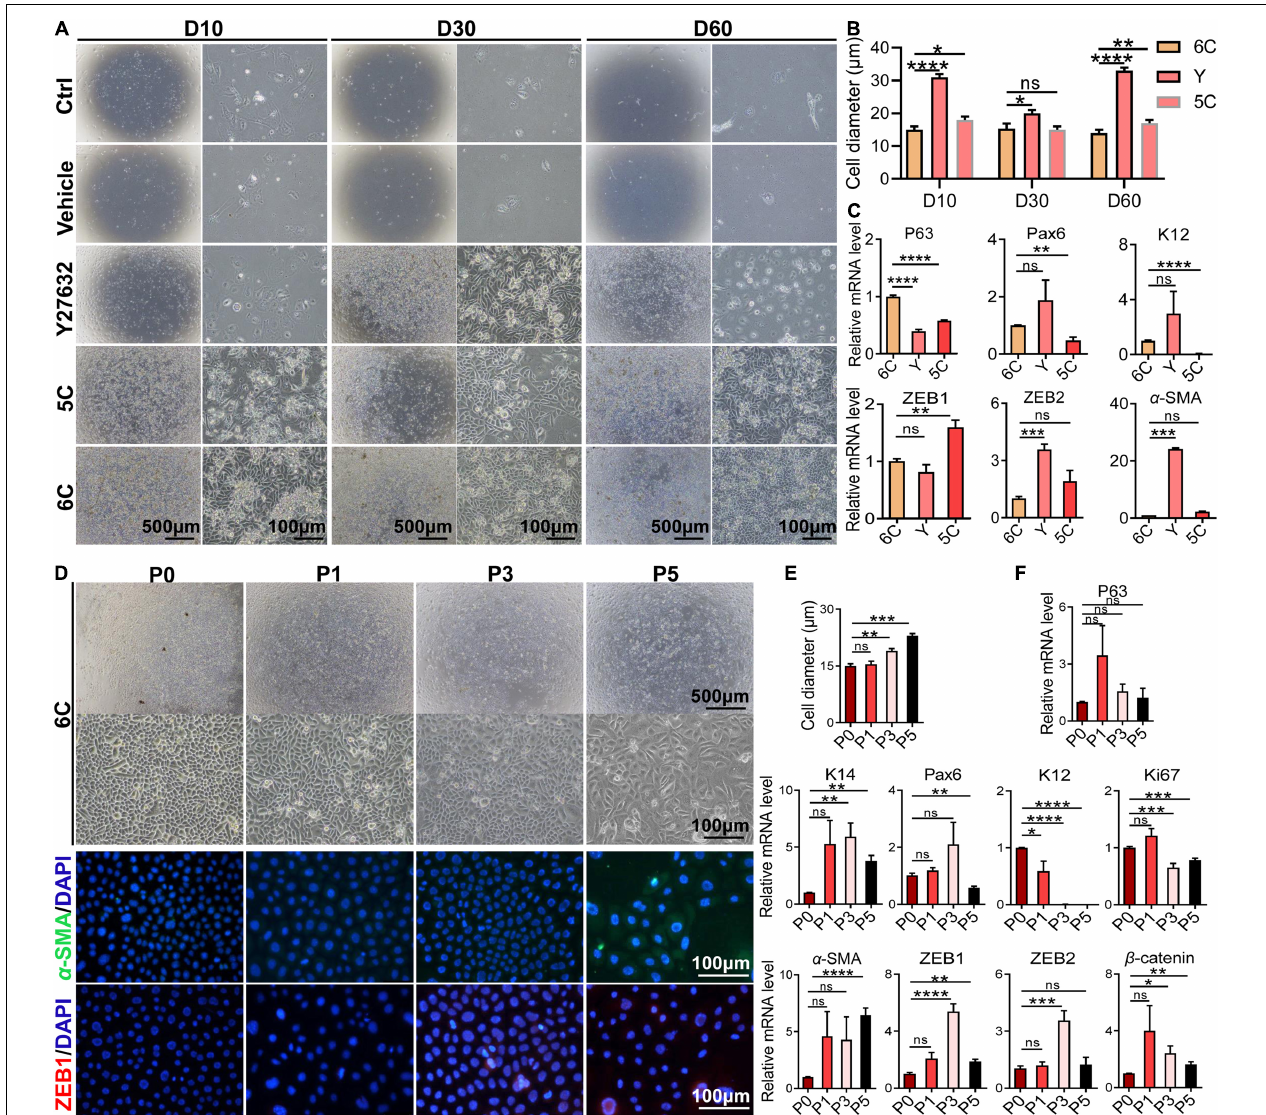
FIGURE 5 | 6C can maintain the morphology and function of mCEC in long-term culture and subculture. (A) Morphological comparison of mCEC cultured with different compositions in long-term culture. (B) Statistical analysis of the diameters of long-term cultured cells. (C) qRT-PCR analysis of P63 , Pax6 , K12 , ZEB1/2 , and α - SMA gene expression (normalized to 6C). (D) Morphology of mCEC subculture. (E) Statistical analysis of the diameters of the cells. (F) qRT-PCR analysis of EMT-related genes, mouse corneal epithelial function-related genes and cell proliferation marker Ki67 (normalized to P0). (G) Immunofluorescence staining of EMT-related genes α -SMA (green) and ZEB1 (red). Nuclei were stained with DAPI (blue). Data expressed as the means ± SEM from three separate experiments (* P < 0.05, ** P < 0.01, *** P < 0.001, **** P < 0.0001, ns: no